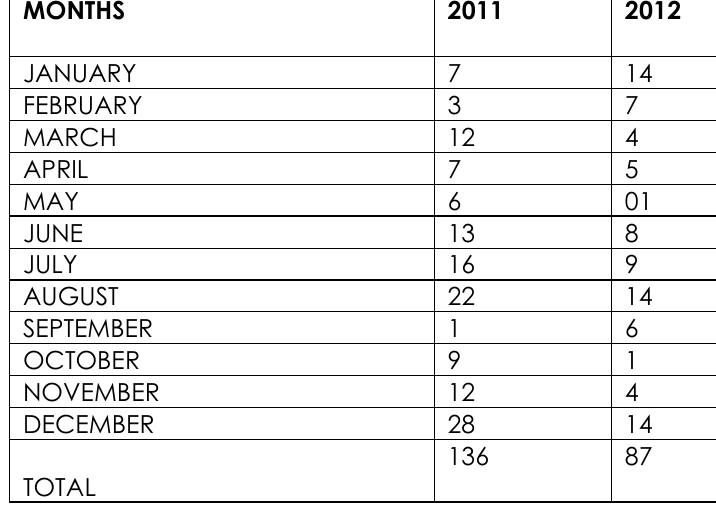
Table 6: Children Traffic Crashes for 2011 and 2012